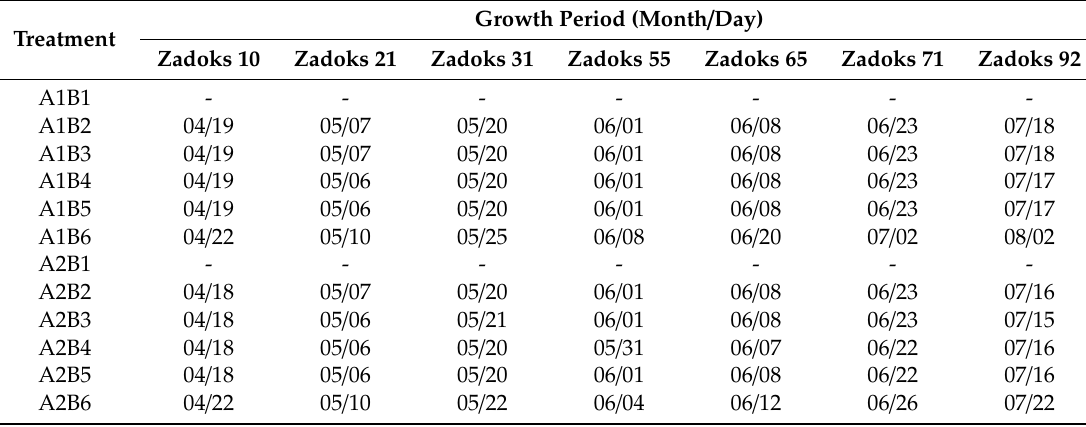
Table 8. The di ff erences in the growth of winter wheat sown on di ff erent dates (2015–2016).